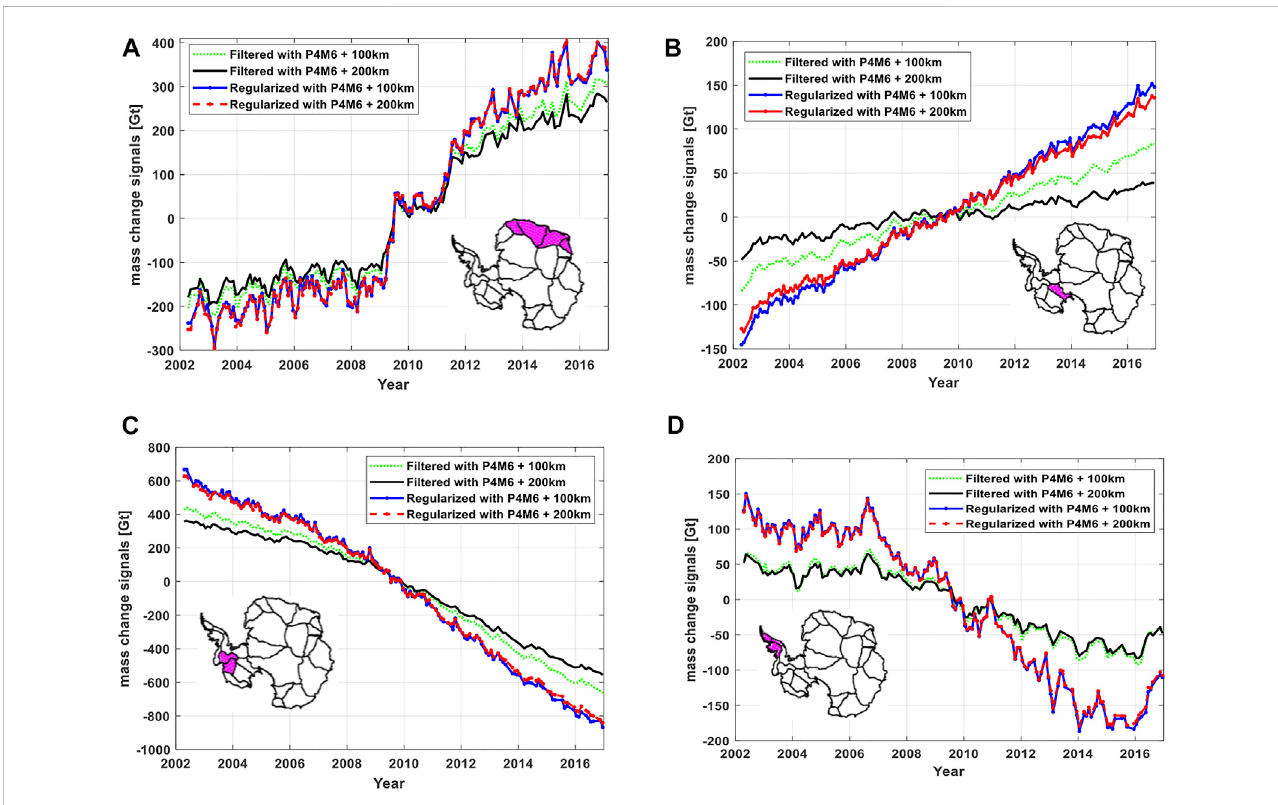
FIGURE 5 Time series of mass change signals derived from two-step fi ltering (P4M6 and Gaussian smoothing with 100 km and 200 km radius) and the corresponding regularized mascon solutions. (A) DML (B) Kamb (C) ASE (D) APIS.